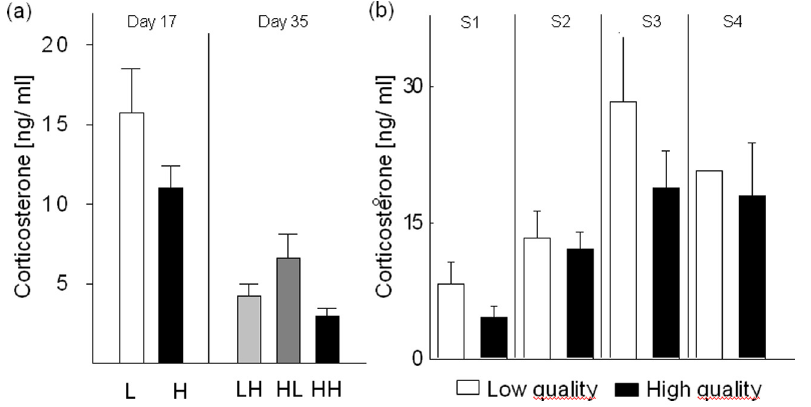
Figure 3. Corticosterone concentrations. a) Mean 6 s.e corticosterone baseline titres at day 17 for subjects raised on low (L) or high (H) quality food and at day 35 when subjects experienced one of the three experimental treatments: low-high (LH), high-low (HL) or high-high (HH). Note: day35 only shows values within detection limits. b) Mean 6 s.e. corticosterone baseline titres at day 17 across individual position within blood sampling sequence (S1–S4) for L- and H-subjects. As only one L- subject was sampled at the forth position (S4) s.e. do not apply.